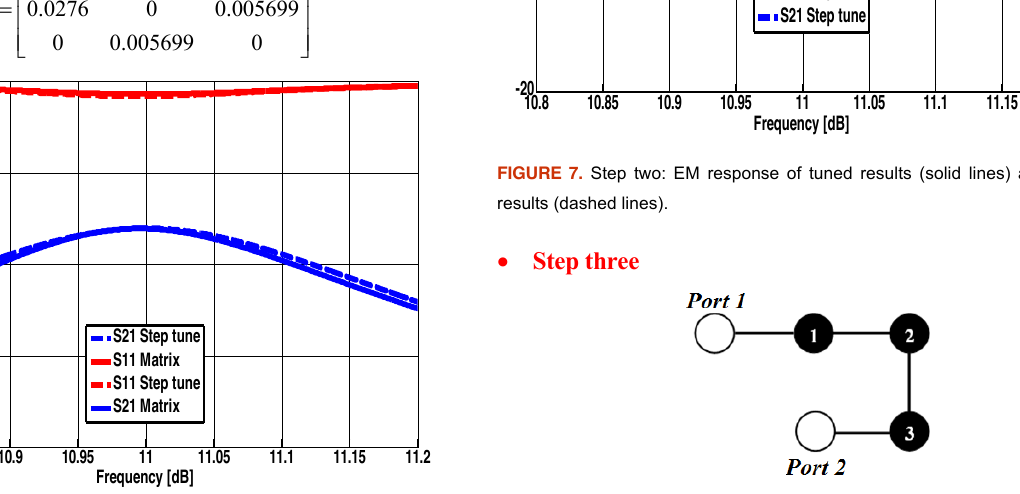
FIGURE 8. Schematic of the resonators 1, 2 and 3 in step